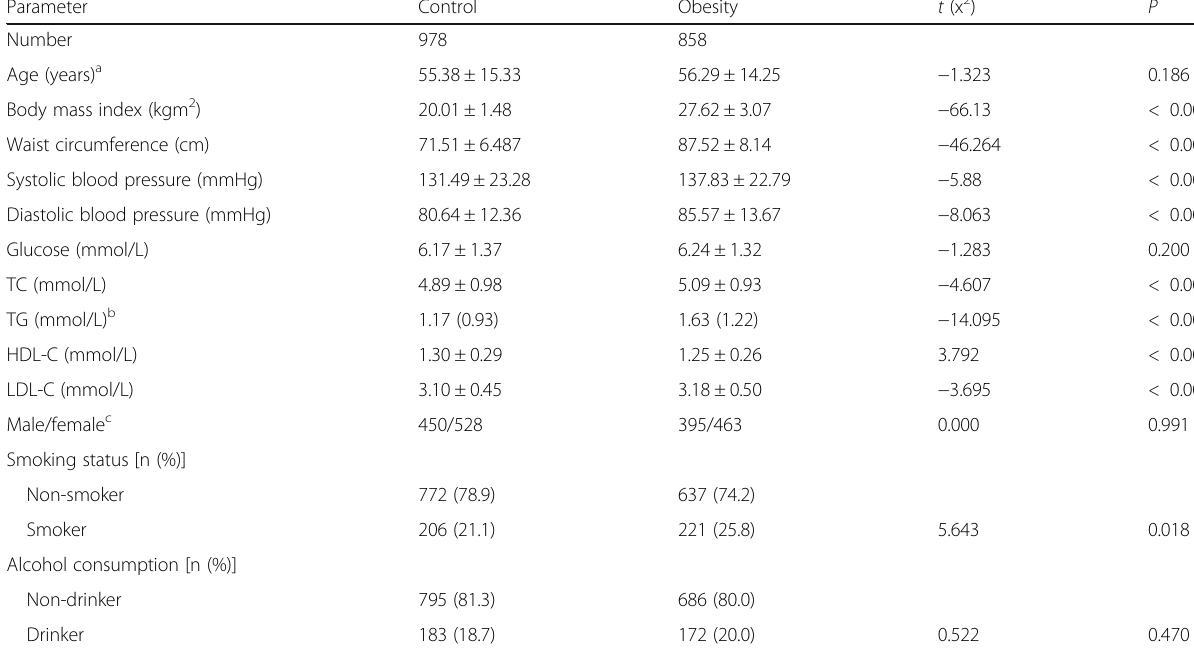
Table 1 Comparison of general characteristics between control and obesity groups Parameter